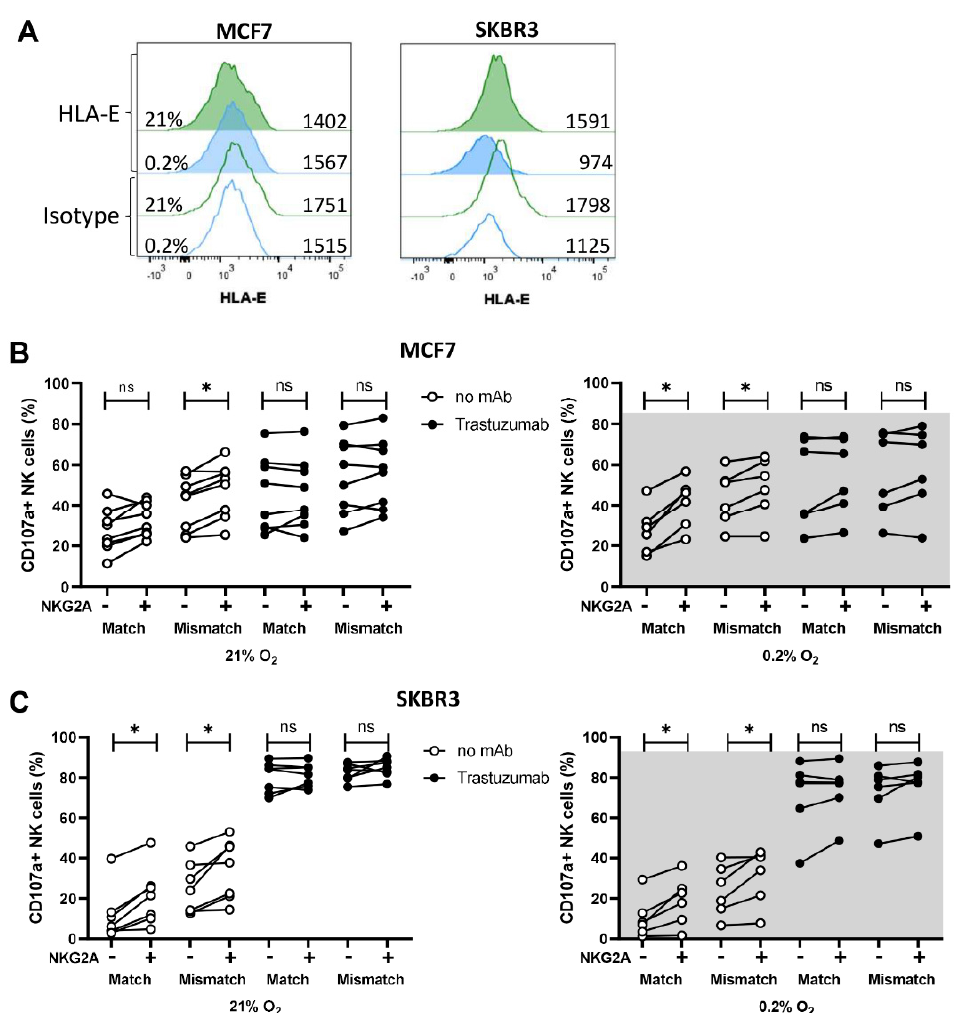
Figure 6. NK cell degranulation of the NKG2A + subsets in comparison to the NKG2A − subsets is slightly enhanced. ( A ) HLA-E expression of MCF7 and SKBR3 was determined by flow cytometry. ( B , C ) For degranulation assays, NK cells were co-cultured either with MCF7 or SKBR3 targets cells with or without trastuzumab for 4 h at 21%O 2 or 0.2% O 2 . By flow cytometry analysis, NK cells were grouped in NKG2A − and NKG2A + subsets (indicated by − and + below graphs) and further divided into KIR-ligand-matched and -mismatched subsets based on their KIR expression. For each subset, NK cell degranulation (CD107a in %) is depicted in response to MCF7 ( B ) or SKBR3 ( C ). Each dot represents one NK cell donor and the average of duplicates. * p < 0.05, ns = not significant.